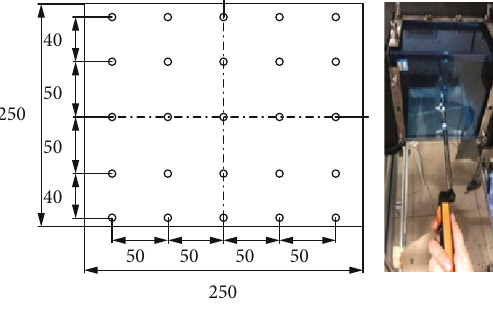
Figure 5: Position of wind speed measurement.